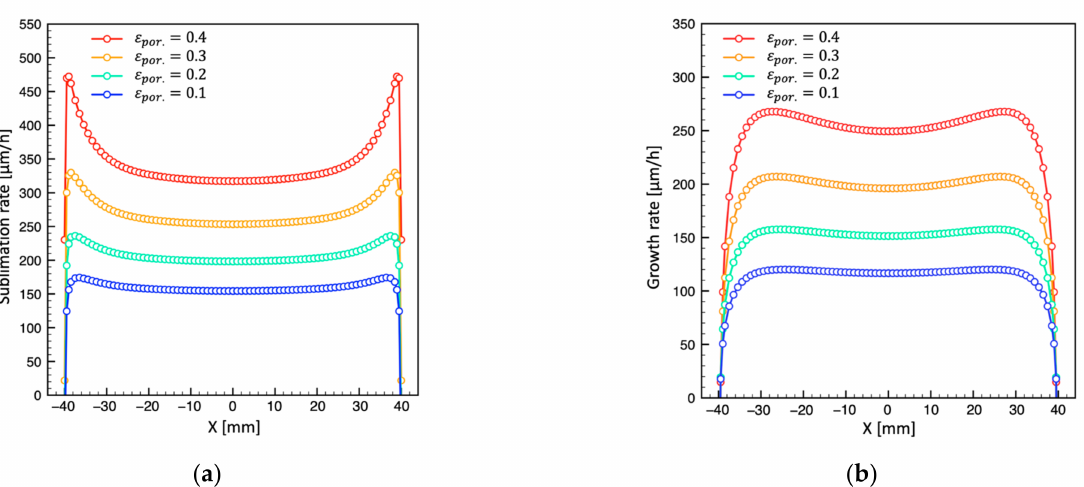
Figure 3. Profiles of the sublimation rate along the top surface of the powder source ( a ) and growth rate along the seed surface ( b ) at various